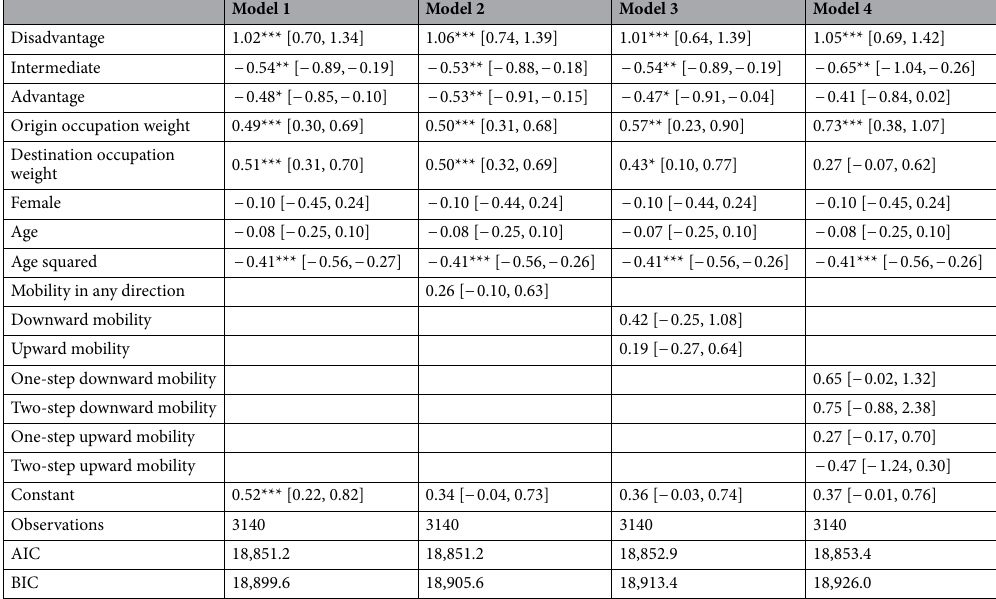
Table 5. DRM parameters estimation [95% confidence interval] for age acceleration indexed by Phenoage algorithm. Models with covariates plus: (1) no mobility variable; (2) any direction mobility variable; (3) variables to indicate upward or downward trend; (4) variables to indicate one step, two step upward or downward trend. 95% confidence intervals in brackets. *p < 0.05, **p < 0.01, ***p < 0.001.